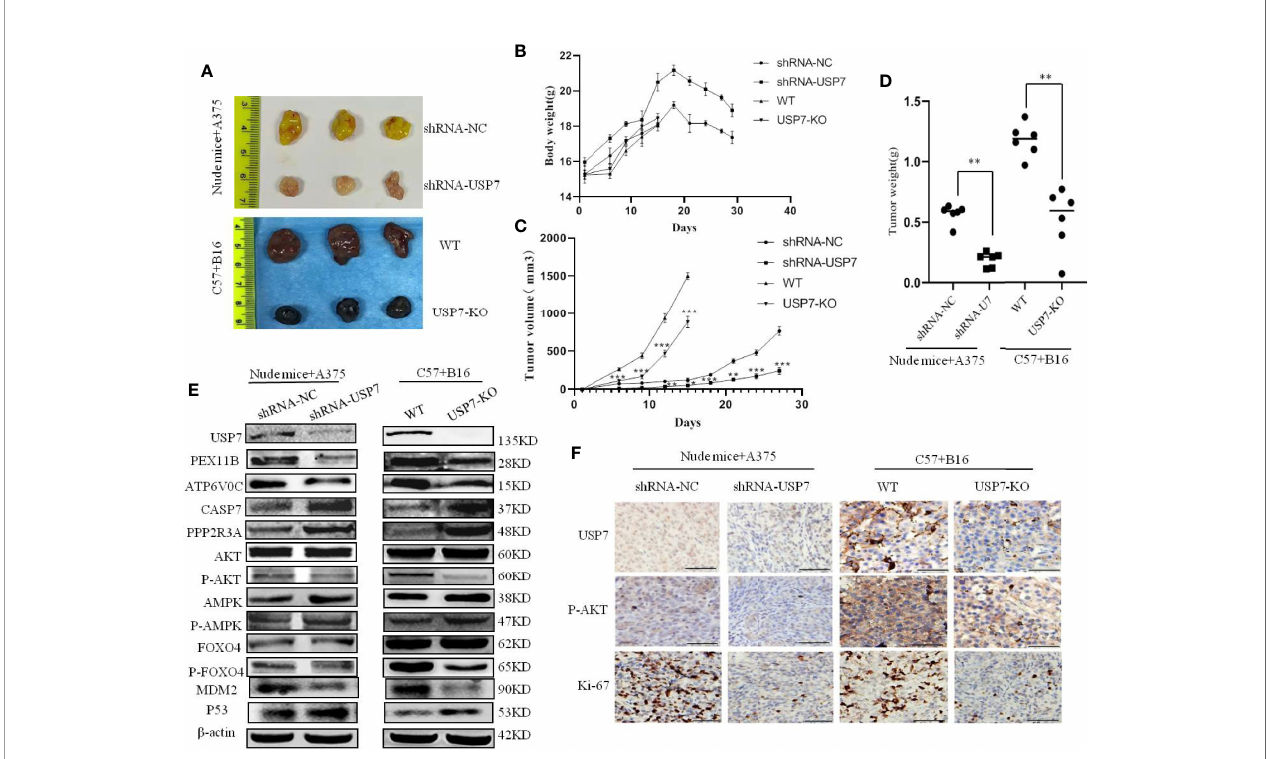
FIGURE 5 | Loss of USP7 function suppresses melanoma tumor growth in vivo . Balb/c nude mice and C57BL/6 mice were subcutaneously transplanted with A375 cells stably expressing USP7 shRNA and USP7-KO B16 cells, respectively, as indicated in the Materials and Methods . (A) Images of harvested mice and tumors after treatment from A375 shRNA-NC cells, A375 shRNA-USP7 cells, B16 WT melanoma cells, or B16 USP7-KO melanoma cells. (B) Mouse weight evolution during the experiment. The values are expressed as the mean. (C) Tumor size was determined by caliper measurement and the data was converted to tumor growth curves. (D) Tumor tissues were harvested and weighed at the end of study (**P < 0.01. Error bar = S.D.). (E, F) Expression of indicated proteins in tumor tissues was measured by western blotting and